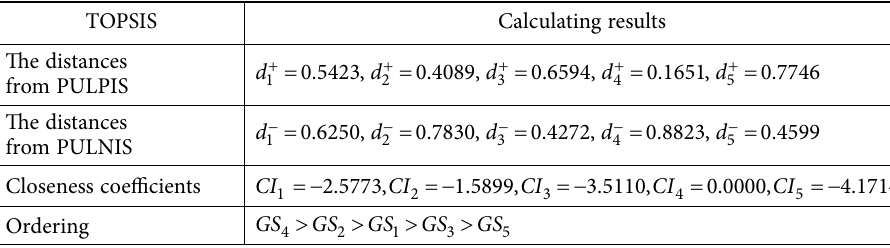
Table 19. The calculating results through PUL-TOPSIS TOPSIS Calculating results The distances from PULPIS The distances from